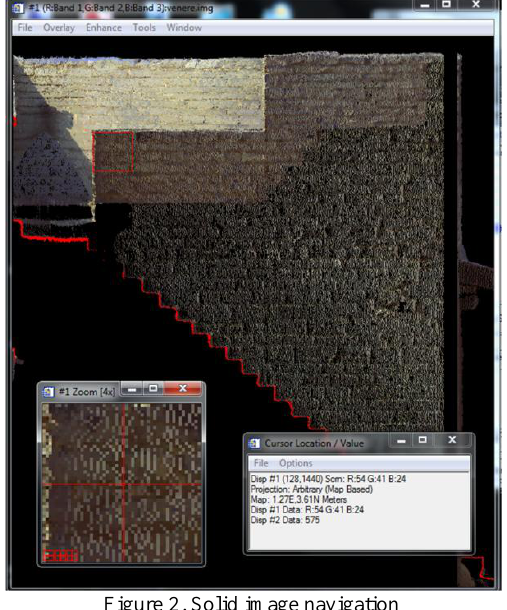
Figure 2. Solid image